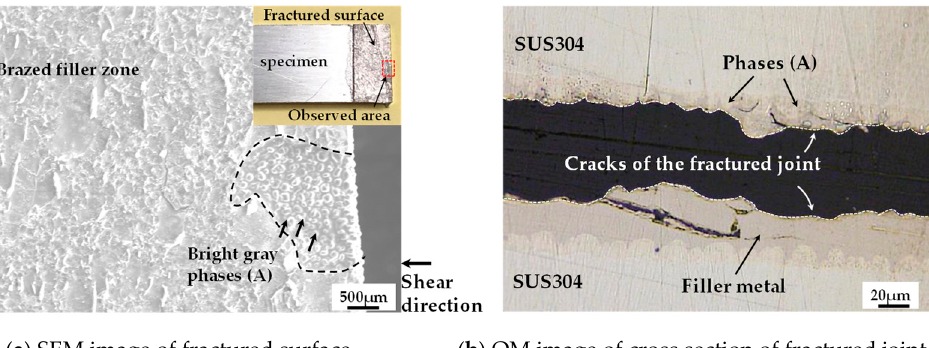
Figure 8. Fracture mode observation of brazed joint.